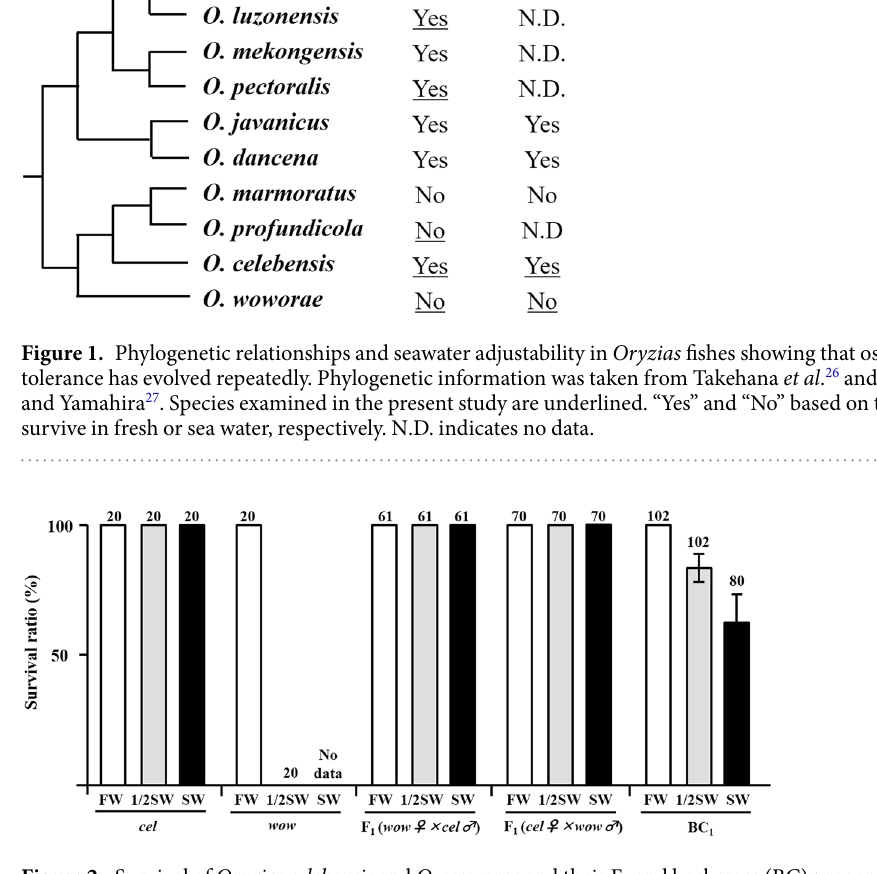
Figure 2. Survival of Oryzias celebensis and O . woworae and their F 1 and backcross (BC) progeny after direct transfer from fresh water (FW) to FW and hypertonic half-strength sea water (SW), and from half-strength SW (1/2 SW) to full-strength SW. BC progeny were obtained by crossing F 1 ( O . celebensis females × O . woworae males) females and O . woworae males. Since all O . woworae died in half-strength SW within 1 week, no data are shown for the survival of O . woworae in SW. cel , O . celebensis; wow , O . woworae . The numbers above the column indicate the total number of individual in each test. Error bars mean standard